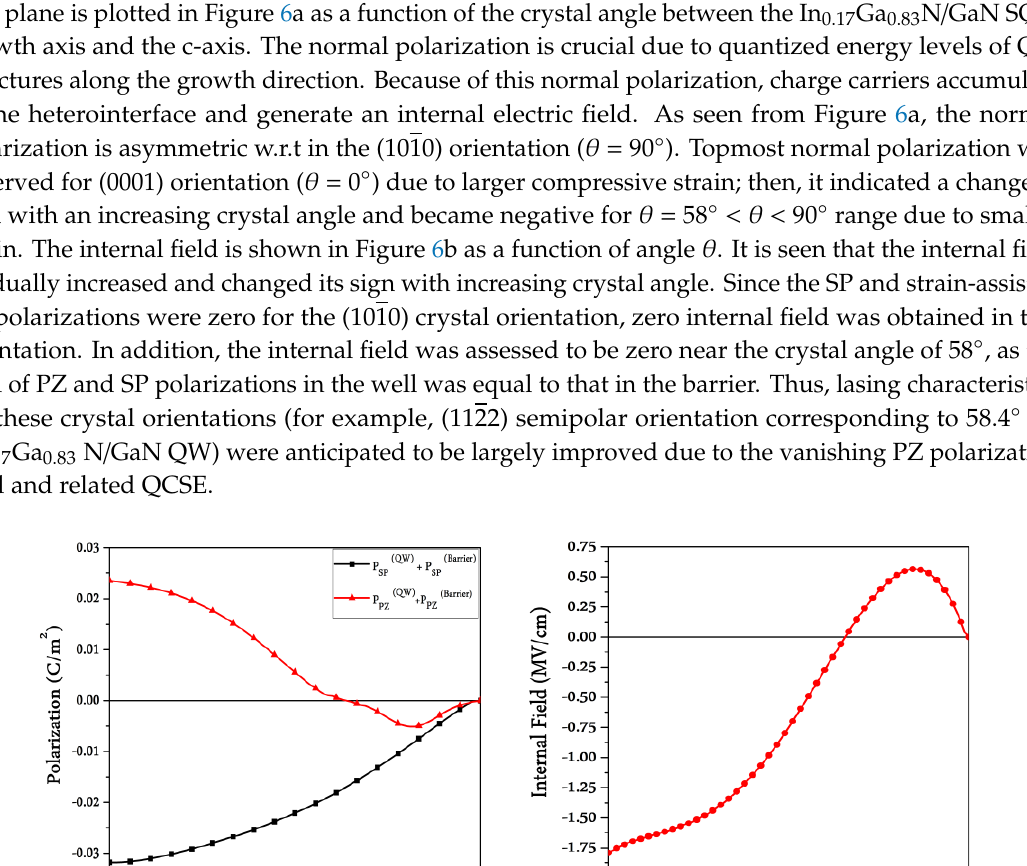
Figure 6. ( a ) The strain-assisted normal piezoelectric and spontaneous polarization w.r.t growth plane for In 0.17 Ga 0.83 N QW and GaN barrier and ( b ) the internal electric filed as a function of crystal angle θ between the growth direction of QW and the c-axis.